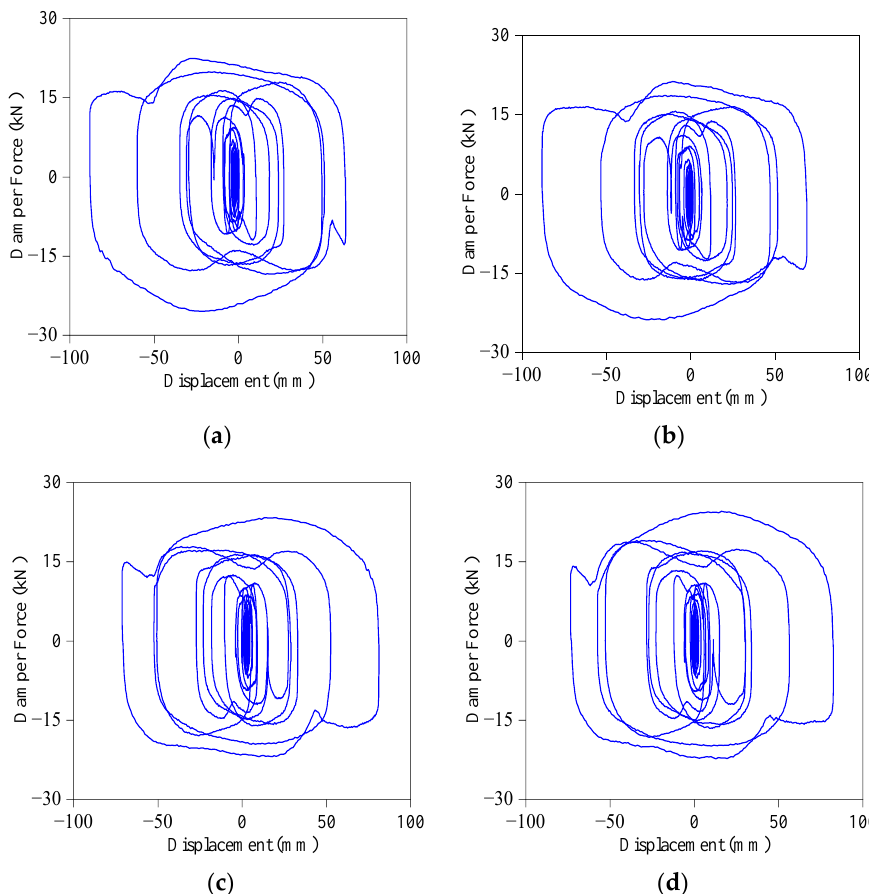
Figure 16. Hysteretic curve of the viscous dampers under Kobe_NP ground motion with a PGA of